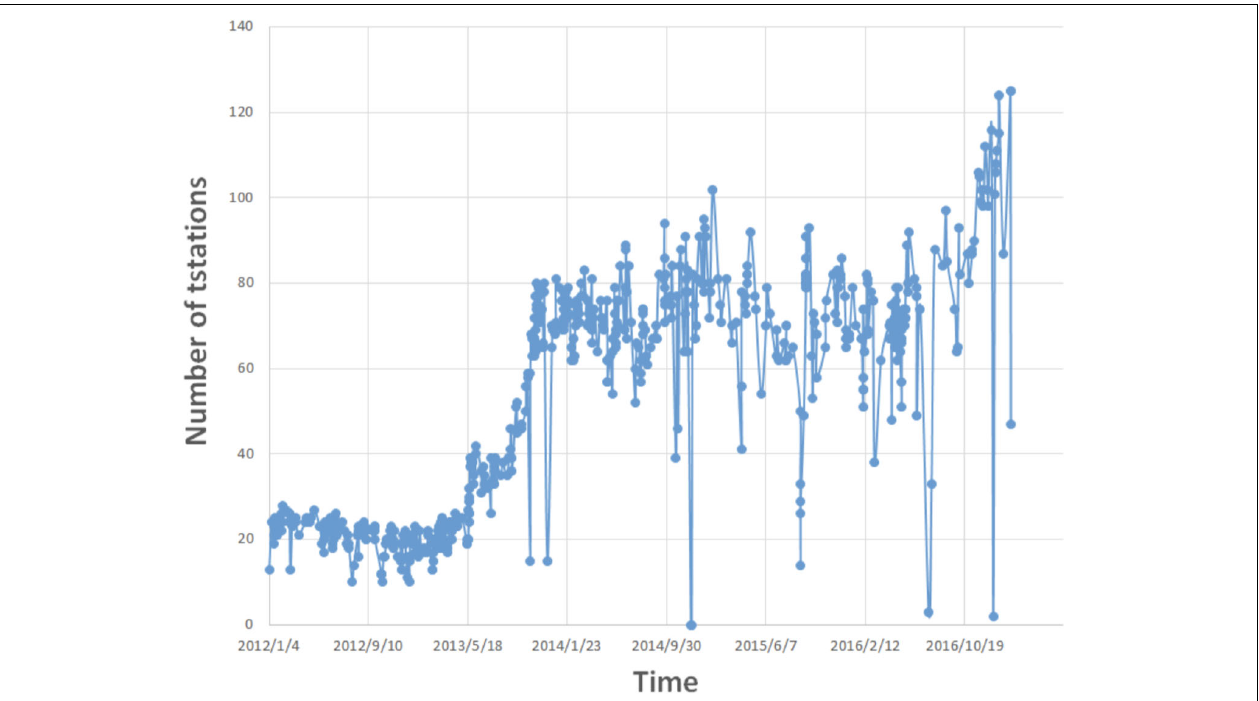
FIGURE 2 | Time history of active QCN in Taiwan since 2012 January to 2016 November. After then the QCN server had encountered an unknown problem leading to an acquisition